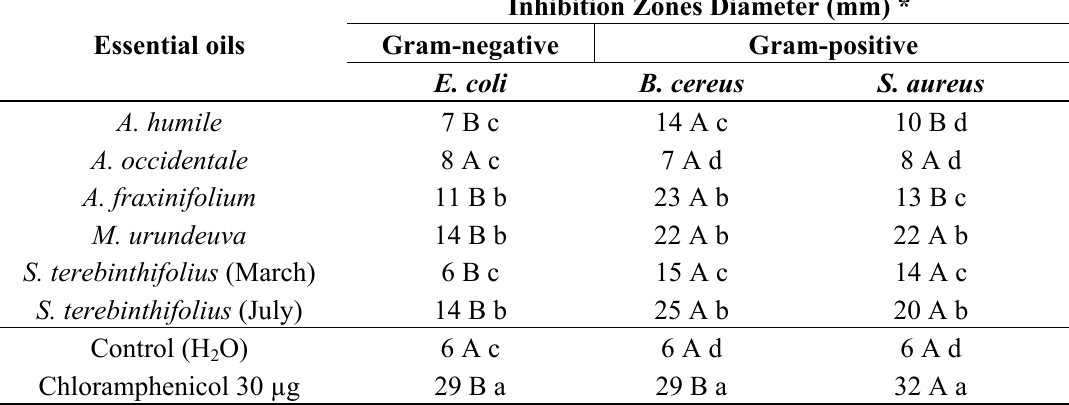
Table 2. Diameter of the inhibition zones of bacterial growth for the essential oils from leaves of the species A. humile , A. occidentale , A. fraxinifolium , M. urundeuva and S. terebinthifolius.